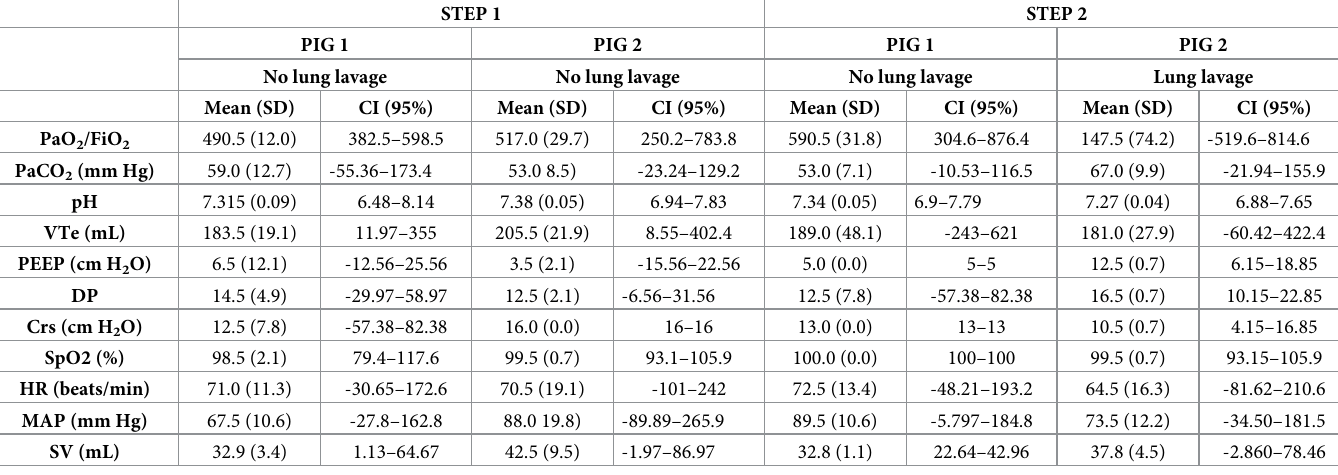
Table 7. Effect of dual ventilation with the ACRA interface of homogeneous (Step 1) and heterogeneous (Step 2) paired animal models on pH, partial pressure of arterial carbon dioxide, ratio of partial pressure of arterial oxygen to the fraction of inspired oxygen, percentage of hemoglobin saturated with oxygen, heart rate, mean arterial pressure, stroke volume, respiratory system compliance, positive end-expiratory pressure, driving pressure and expired tidal volume.